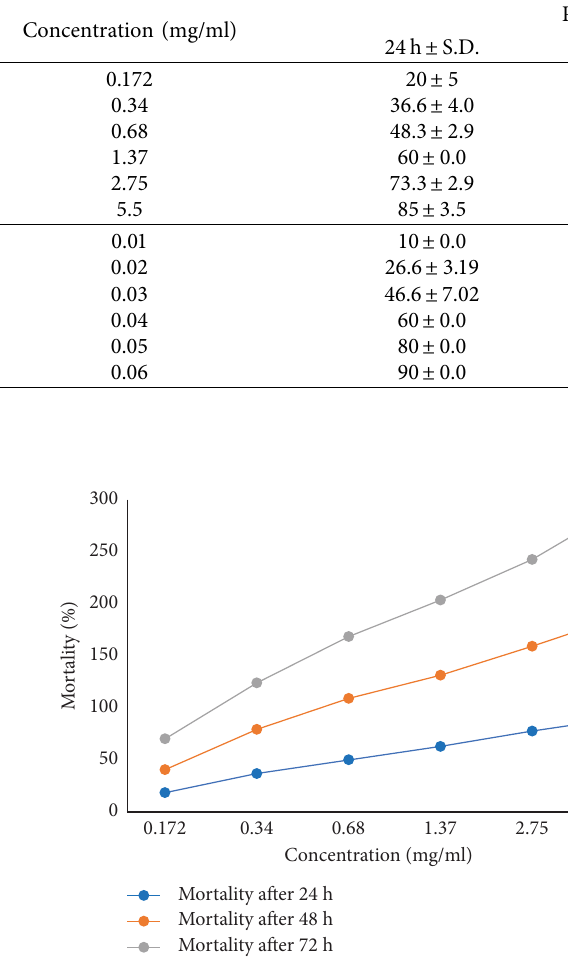
Figure 1: Mortality percentage in D. stramonium crude protein stem extract at diferent concentrations of protein solution.